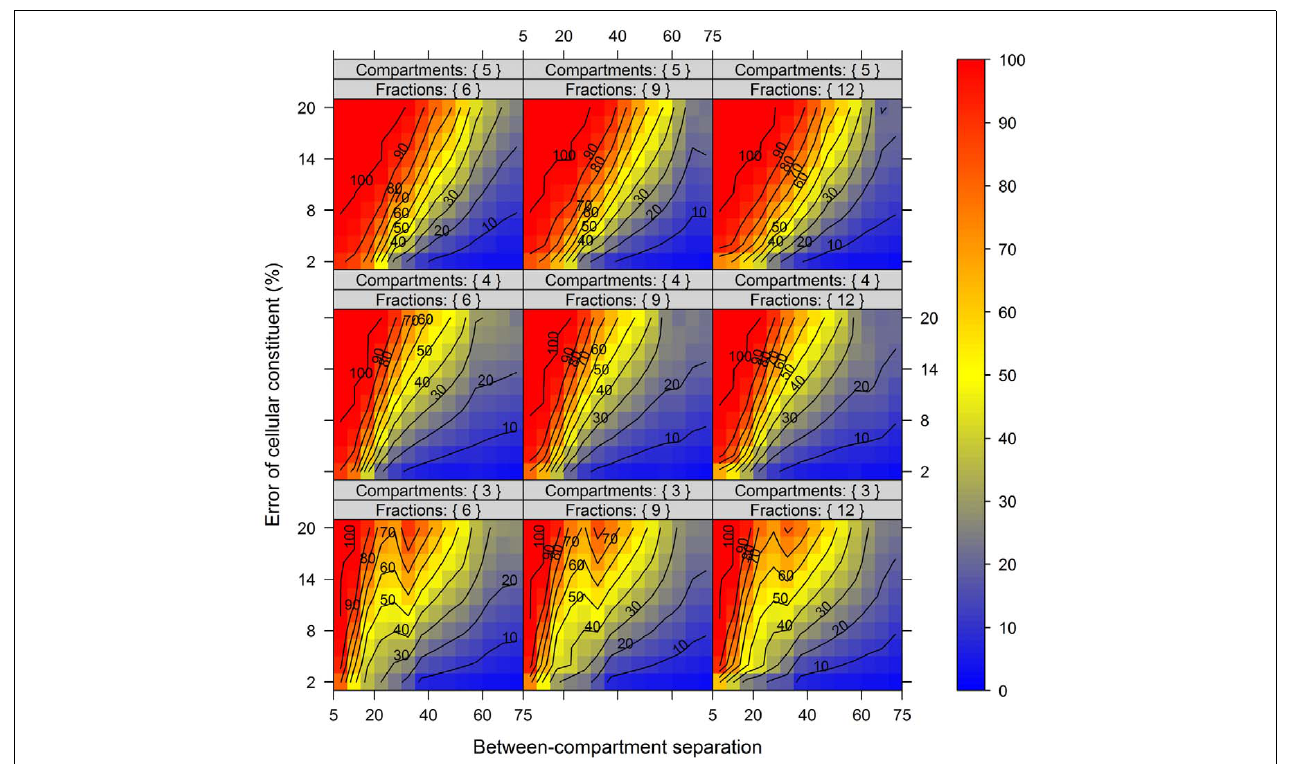
99th percentile for each combination of between-compartment separation and metabolite error in dependence of the number of compartments (3–5) and number of fraction (6, 9, and 12) considered. For further details see FigureA7